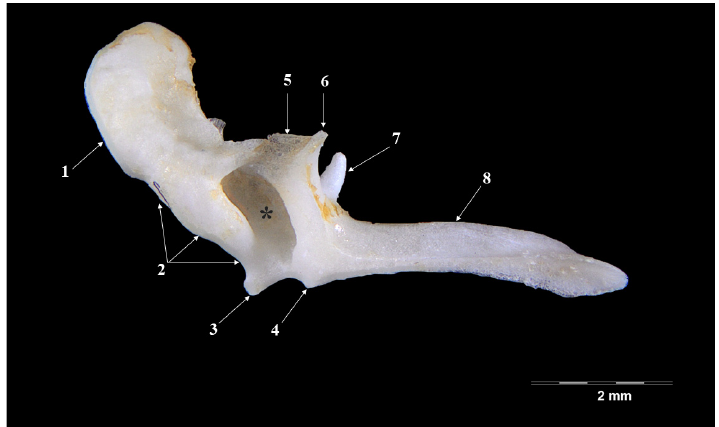
Figure 2. Malleus-lateral perspective. 1. Caput mallei; 2. Collum mallei; 3. Processus lateralis— upper segment; 4. Processus lateralis, lower segment; 5. Lamina; 6. Processus rostralis; 7. Processus muscularis; 8. Manubrium mallei; *—innominate fossa. The neck of the malleus continues in an oral-ventral direction to the head of the ossi- cle. This segment seems quite short, with a series of processes placed very closely, one to another. A rostral process ( Processus rostralis ), the most developed one, detaches from the oral-ventral part of the neck, and appears as an almost-cylindrical pointed bone piece linked to the ventral part of the neck by a fine osseous blade. The muscular process ( Pro- cessus muscularis ) is a long piece (Table 1) that detaches from the medio-caudal part of the neck. This process serves as insertion point for the tensor muscle of the tympanic mem- brane ( M. tensor tympani ). The lateral process ( Processus lateralis ) appears as two small tu- berosities separated by a depression onto the dorsal part of the neck, close to the junction of the neck ( collum ) with the handle ( manubrium ). The handle of malleus continues the neck as a ventral projection towards the tym- panic membrane. It is an elongated (Table 1), triangular in transversal section piece, show- ing a lateral basal part and a tip medially. In its distal part, the manubrium becomes flat- tered and curves medio-laterally. An overall observation indicates a relatively reduced angulation for the manubrium and neck of the malleus, a fact that makes it comparable to the overall aspect of a hockey stick. The incus (Figures 3 and 4), smaller than the malleus (Table 1), continues from the malleus and has the overall aspect of a biradicular molar. Onto its surface, a series of mor- phological segments can be described and identified: the body ( Corpus incudis ), the short crus ( Crus breve ) and the long crus ( Crus longum ). The body of the incus appears as a well-developed piece, wider than long, with an evident articular malleal surface ( articulatio incundomallearis ) on its anterior extremity. From its caudal part, the two crura projects as slightly divergent processes, giving the extremity the shape of V letter. The short crus ( crus breve ), shorter and tronconic-shaped, continues to the dorsal margin of the ossicle in a dorso-caudal direction. The long crus, in a more-acute angle, continues to the ventral margin of the ossicle, with a long, pointed or effilated shape (see Table 1).